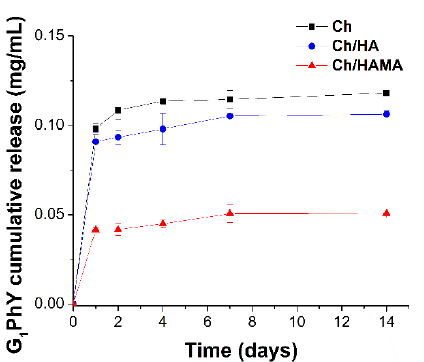
Figure 5. Release profiles of G 1 Phy from the Ch, Ch/HA and Ch/HAMA membranes in 0.1 M Tris bu ff er (pH 7.4) at 37 ◦ C. Data represented the mean ± buffer (pH 7.4) at 37 °C. Data represented the mean ± SD.